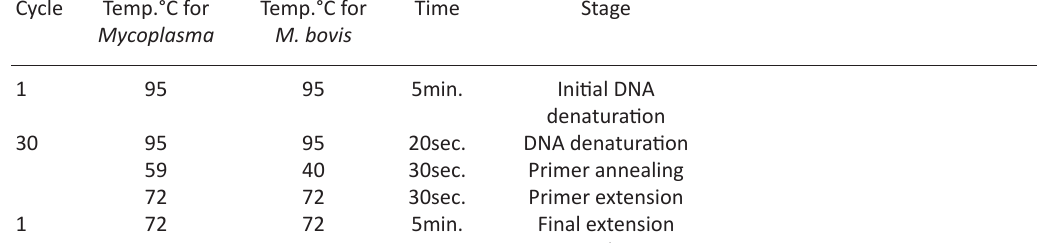
Table 3. Thermocycler program for detection of Mycoplasma and M. bovis Cycle Temp.°C for